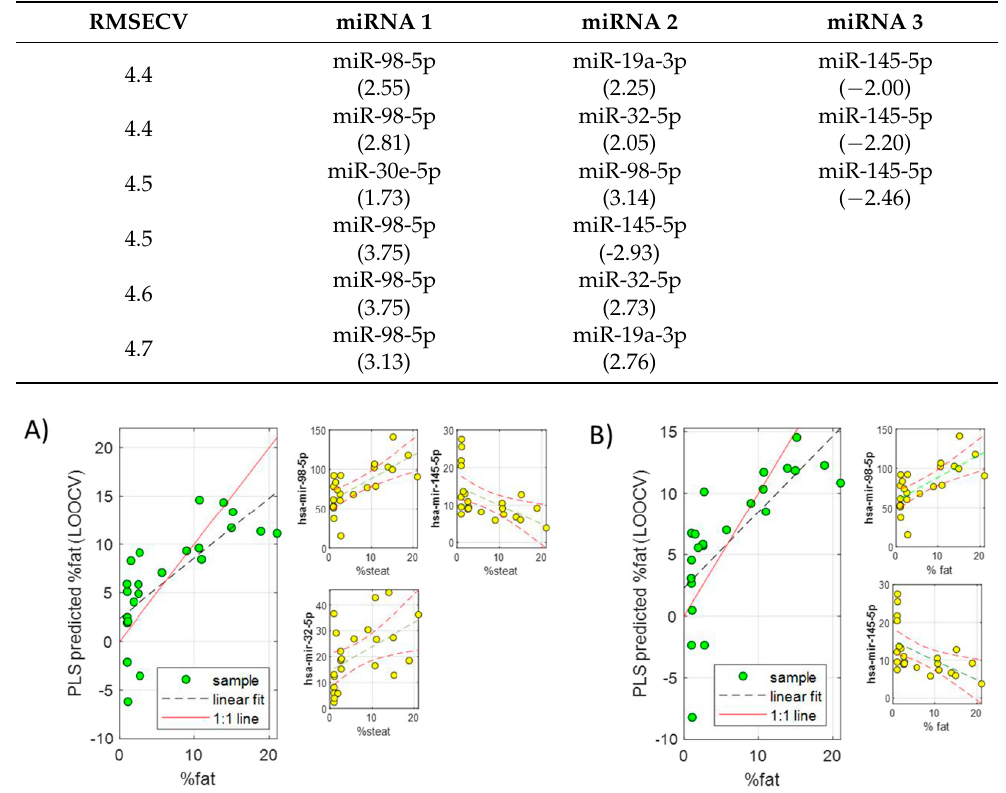
Figure 4. Predicted liver fat % by LOOCV in two PLS models built using two serum miRNA subsets including three ( A ) or two ( B )